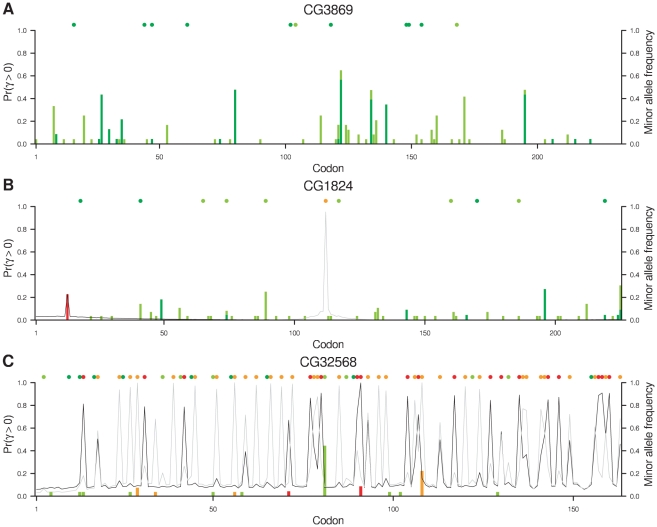
Evidence for positive selection in three genes.At each codon, the posterior probability of positive selection is plotted for D. melanogaster (dark grey line) and D. simulans (light grey line). To illustrate the signal in the data, the figure is superimposed with the sample frequency of polymorphisms in the two species (vertical bars) and substitutions along the two lineages (filled circles, above). The colors indicate synonymous variants in D. melanogaster (dark green) and D. simulans (light green) and non-synonymous variants in D. melanogaster (red) and D. simulans (orange).